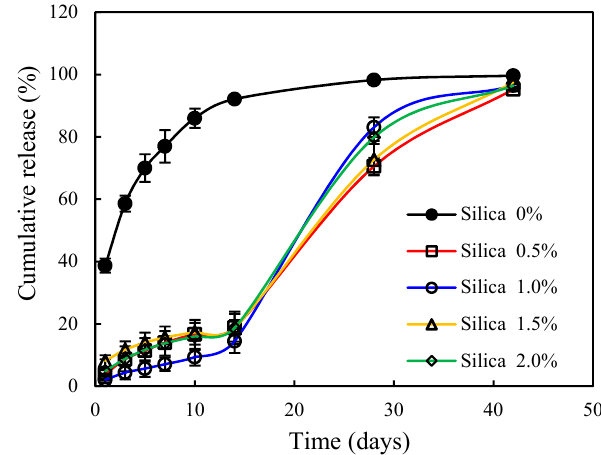
Figure 1. Nutrient cumulative release profiles of controlled release urea coated with polyacrylate emulsion (silica 0 wt.%) and hybrid emulsions with 0.5 wt.%, 1.0 wt.%, 1.5 wt.%, and 2.0 wt.% silica spheres. Table 1. Preliminary solubility and release duration of controlled-release urea (CRU). Silica Content (wt.%)